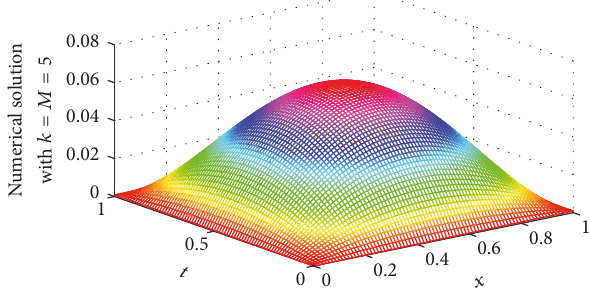
Figure 5: Numerical solution with 𝑘 = 𝑀 = 5 .